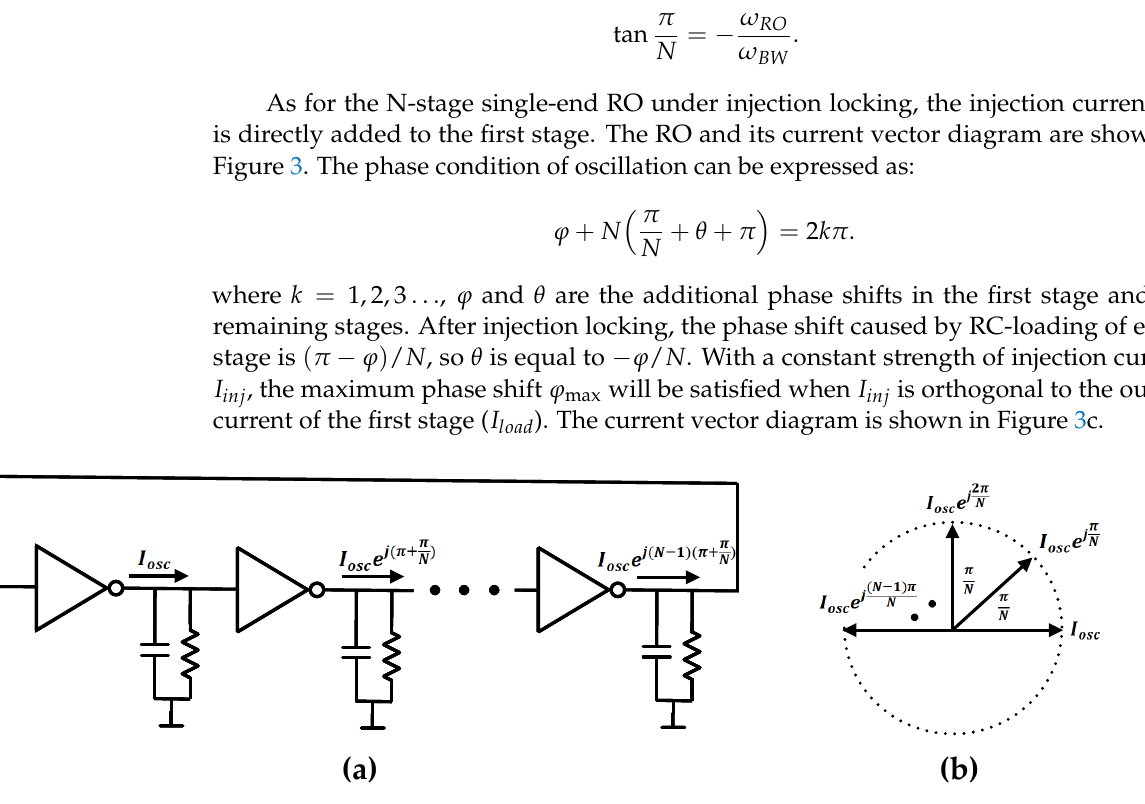
Figure 2. ( a ) N-stage single-end ring oscillator; ( b ) Current vector